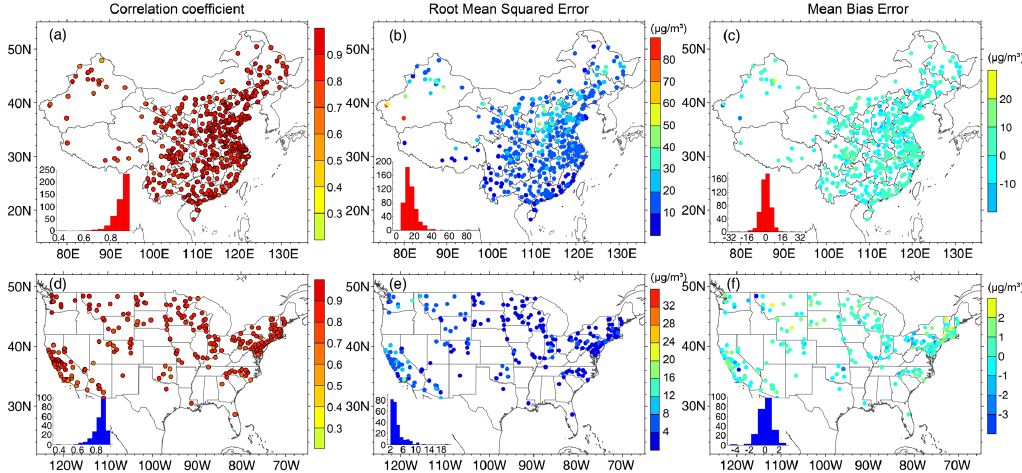
Figure 8. Data accuracy of PM 2.5 forecasts from the European Copernicus Atmosphere Monitoring Service (CAMS) with a forecasting time horizon of 3 h (step-3) in China ( a – c ) and United States (US) ( d – f ). The subplot in each figure shows the histogram of the corresponding statistical